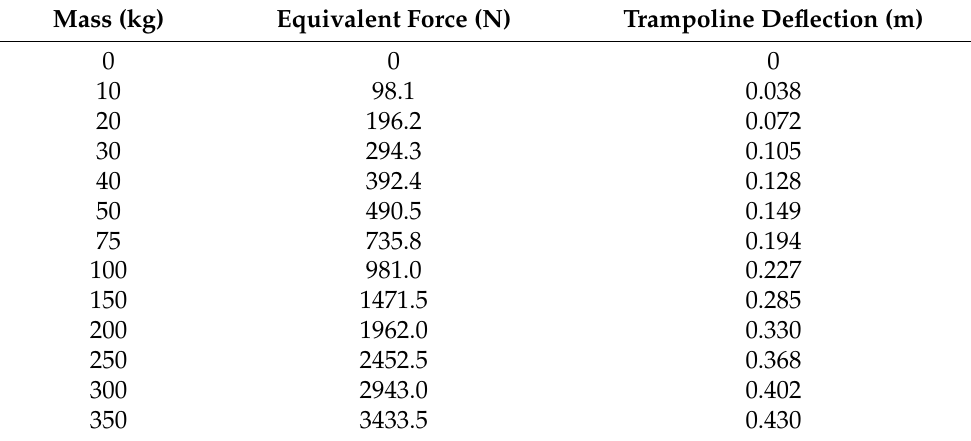
Table 2. Trampoline static deflection under different external